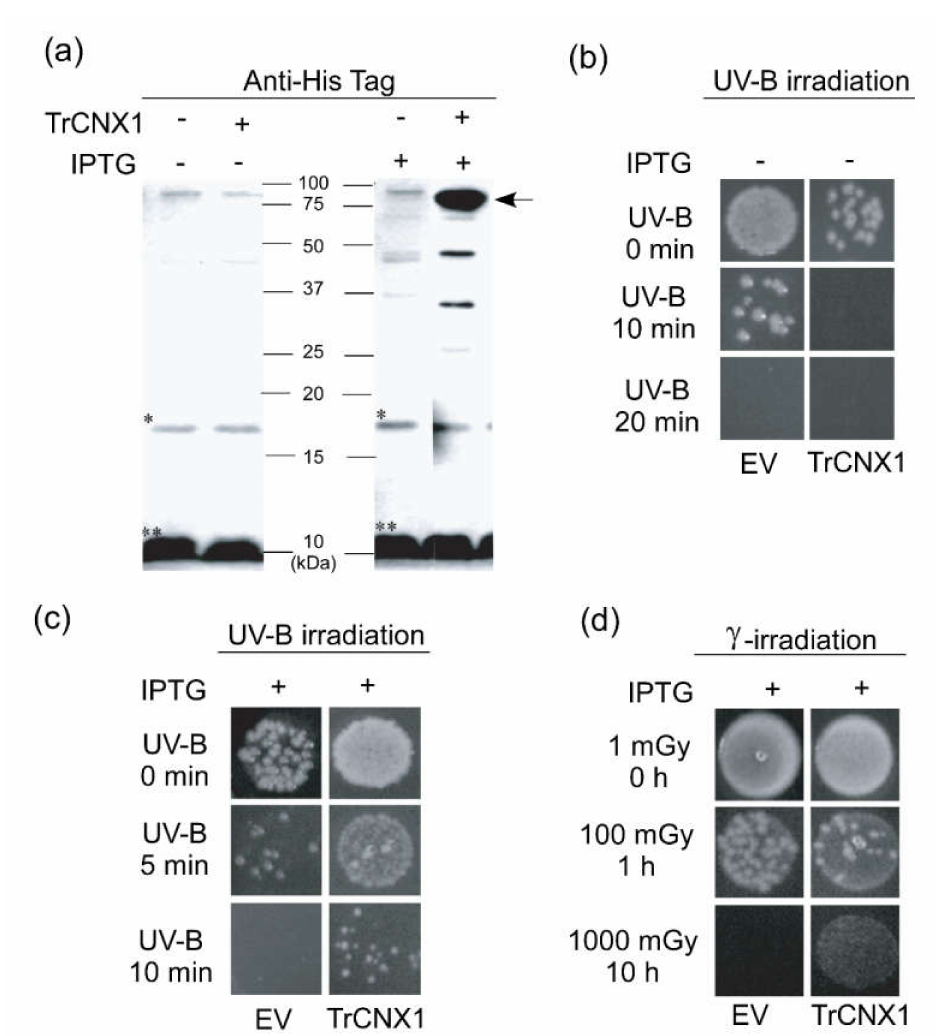
Figure 5. Analysis of recombinant TrCNX1 fusion proteins in Escherichia coli BL21(DE3) and growth of TrCNX1-expressing E . coli under irradiation stress (UV-B and È -IR). ( a ) Western blot analysis of overexpressed recombinant TrCNX1 fusion proteins in E . coli with anti-His tag antibodies. The left and rightpanelsdenotethetotalproteinsof E . coli cellswithout(–)andwith( + )isopropyl-b-D-thiogalactoside (IPTG) induction, respectively. A protein ladder of 10–100 kDa is shown parallel to lanes indicating band sizes. Overexpressed TrCNX-1 is indicated by an arrow, while non-specific bands are shown by ‘* or **’. ( b ) Cell viability of E . coli transformants without IPTG induction in response to UV-B stress for 0, 10, and 20 min. Exponentially growing E . coli transformants of EV (harboring pET-28a empty vector (BL / EV) and TrCNX1 (harboring pET -28a-TrCNX1 [BL / TrCNX1 ]) in liquid LB medium (without [–] IPTG supplement)) were serially diluted (1:10) and spotted on solid LB medium (with 50 µ g / mL of kanamycin). Spotted plates were then subjected to UV-B stress. ( c ) Viability of ( + ) IPTG induced E . coli transformants under UV-B stress for di ff erent time points. ( d ) Viability of ( + ) IPTG-induced E . coli transformants in response to di ff erent doses of (100 and 1000 mGy) È -IR stress for di ff erent times (1 and 10